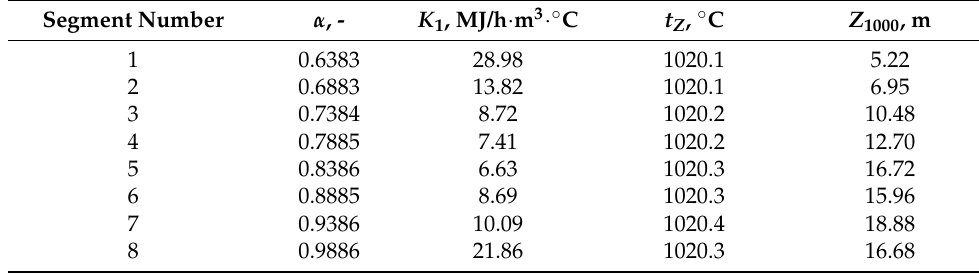
Table 3. Reserve zone parameters and